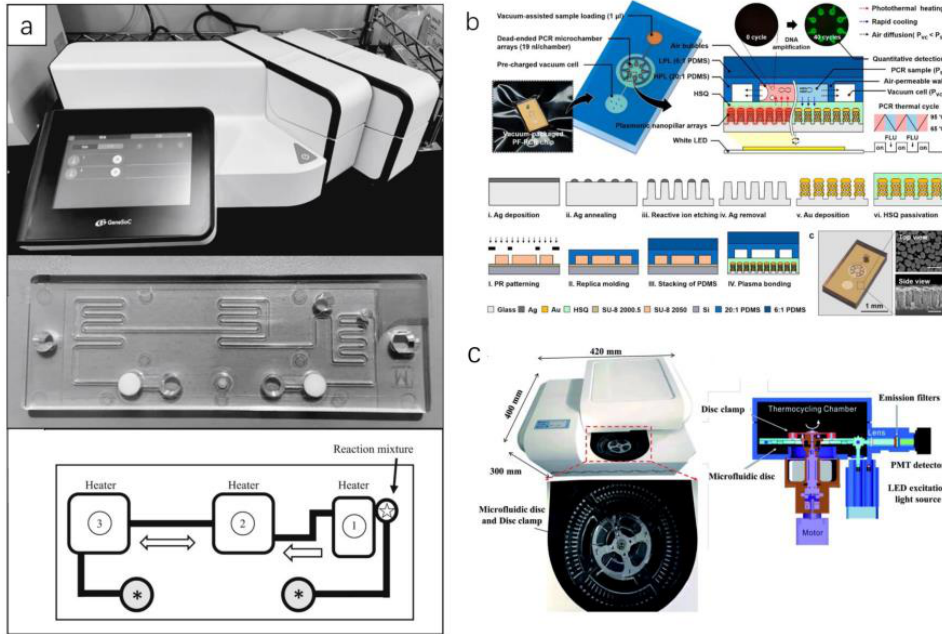
Figure 6. Detection of SARS-CoV-2 by PCR on microfluidic. ( a ) Schematic diagram of space domain PCR equipment, microfluidic chip, and liquid flow [17]. ( b ) Vacuum-assisted nanoplasmonic on-chip polymerase chain reaction [67]. ( c ) Thermocycling and optical detection in microfluidic devices, microfluidic chips, and devices [63]. (Copyright © 2020 The Healthcare Infection Society. Published by Elsevier Ltd. All rights reserved.) (Copyright © The Royal Society of Chemistry 2020) (Copyright © 2021 The Authors. Published by American Chemical Society). Table 4. The data and applications of on-chip PCR detection technology were summarized.